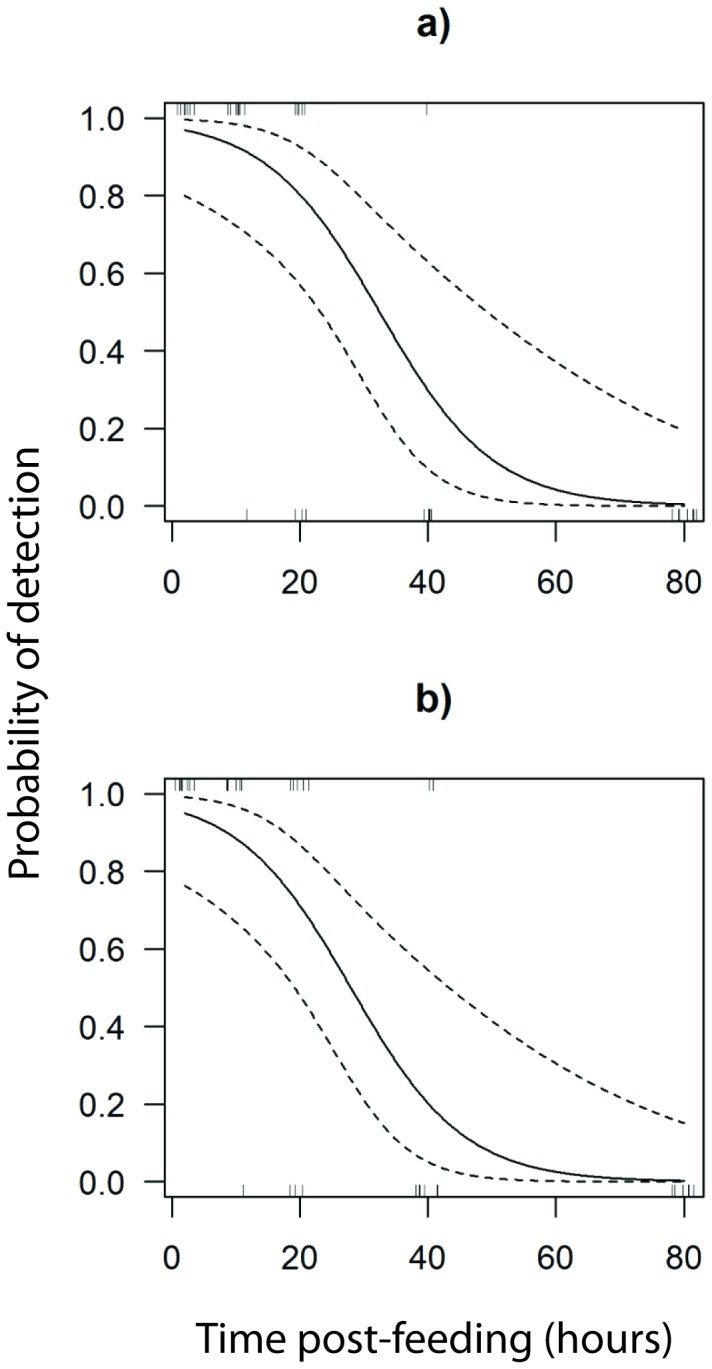
Detection period of prey DNA in the foreguts of Carabus nemoralis fed with Arion
distinctus and A. silvaticus using the 12S rRNA multiplex PCR and the singleplex PCR for cox1, respectively.The solid line represents the binomial model, while the dotted lines represent the upper and lower 95% confidence limits. The vertical lines represent the replicates and one line may in some cases consist of more than one replicate. (a) The detection of A. distinctus (f (E[y]) = 3.663 – 0.113x, AIC = 28.531, df = 37, p = 0.002, median detection period = 27.9 h). (b) The detection of A. silvaticus (f (E[y]) = 3.166 – 0.114x, AIC = 38.856, df = 37, p = 0.001, median detection period = 32.4 h).